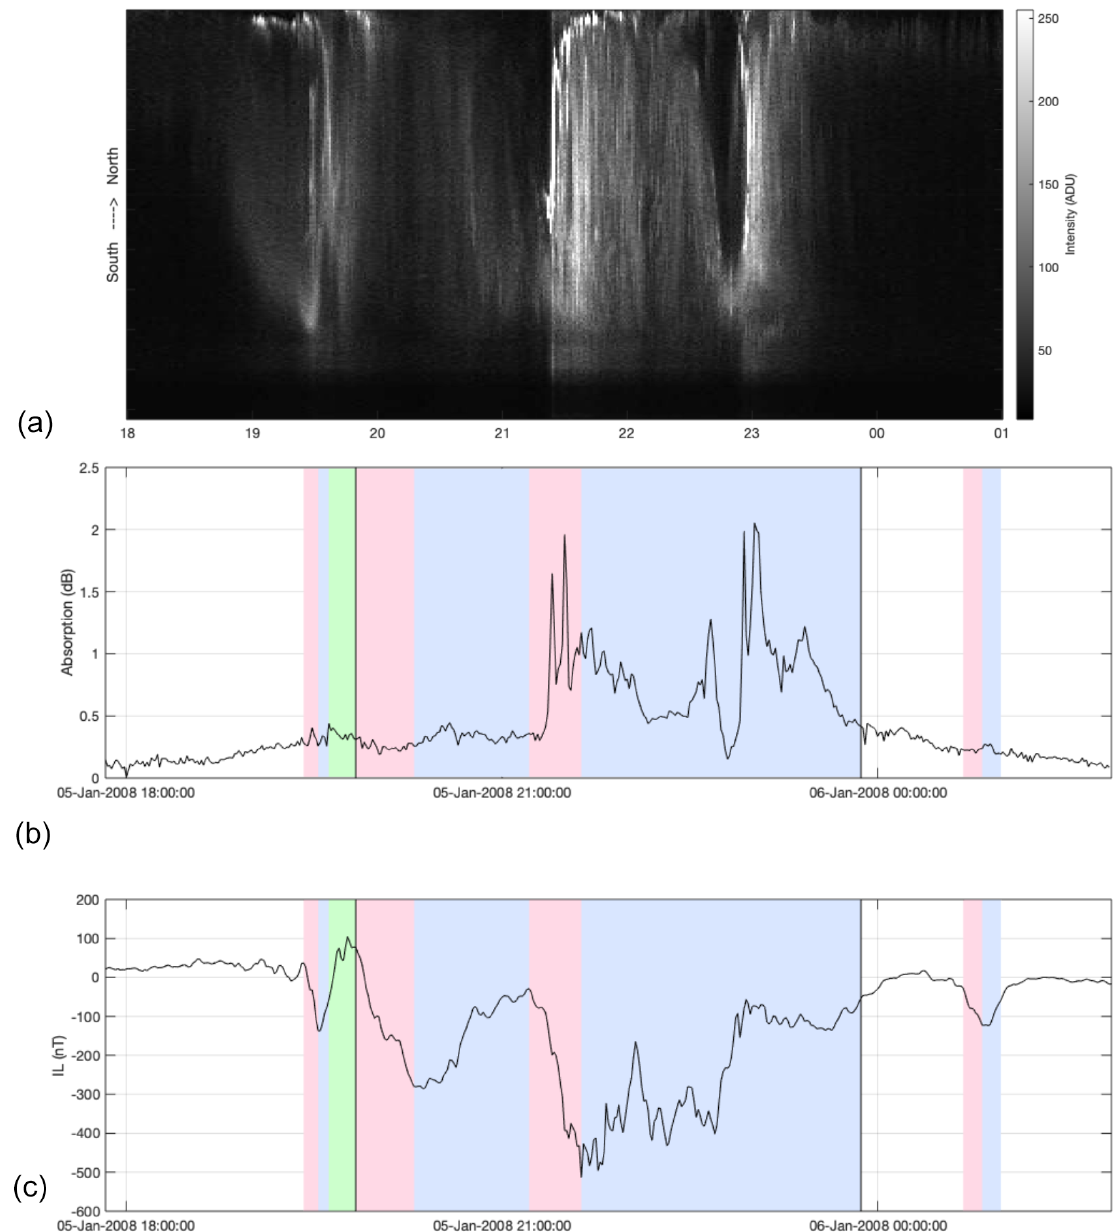
Figure 2. An example of a compound substorm event with several consecutive expansion (red) and recovery (blue) phases. The vertical lines mark the time period which is used in the analysis, i.e. from the expansion onset until the end of the recovery phase. The green shaded area marks the growth phase as determined by the search algorithm. Displayed is the temporal evolution of CNA (b) and IL (c) . Panel (a) shows the evolution of the green auroral emission as a keogram (north–south slice as a function of time) from the SOD camera station aligned to match the timing of data in b and c